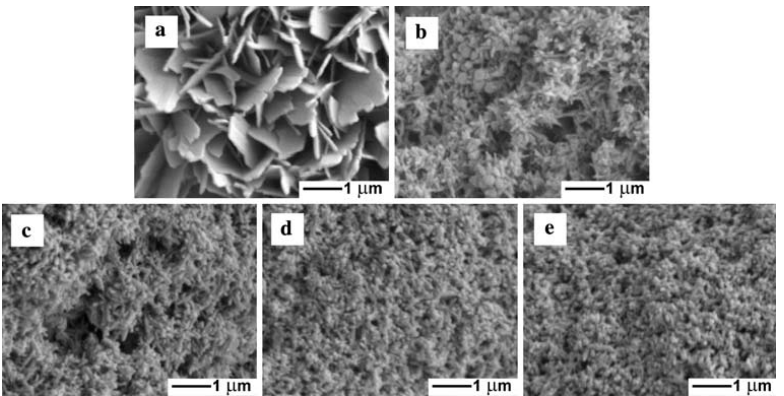
Figure 6. Scanning electron microscopy (SEM) micrographs of the samples prepared by sonoelectrodeposition under different current densities. ( a ) 5 mA/cm 2 ; ( b ) 8 mA/cm 2 ; ( c ) 13 mA/cm 2 ; ( d ) 20 mA/cm 2 ; and ( e ) 34 mA/cm 2 . Reprinted from [31] with permission of Springer.